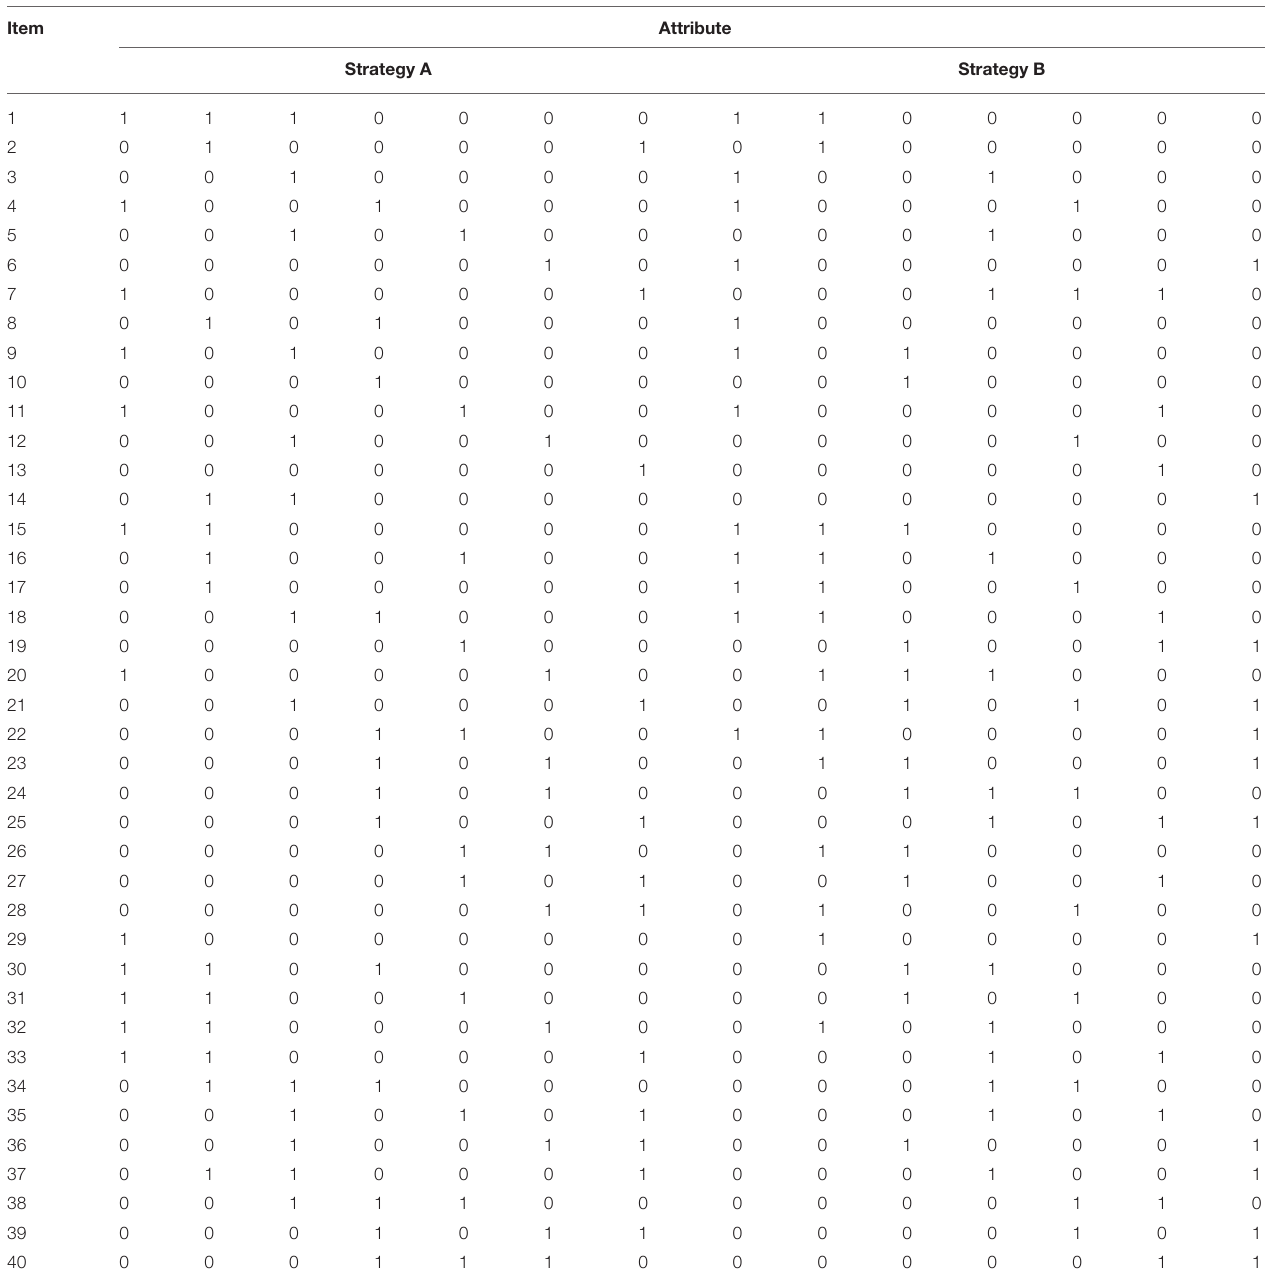
TABLE 4 | The Q matrix design in simulation